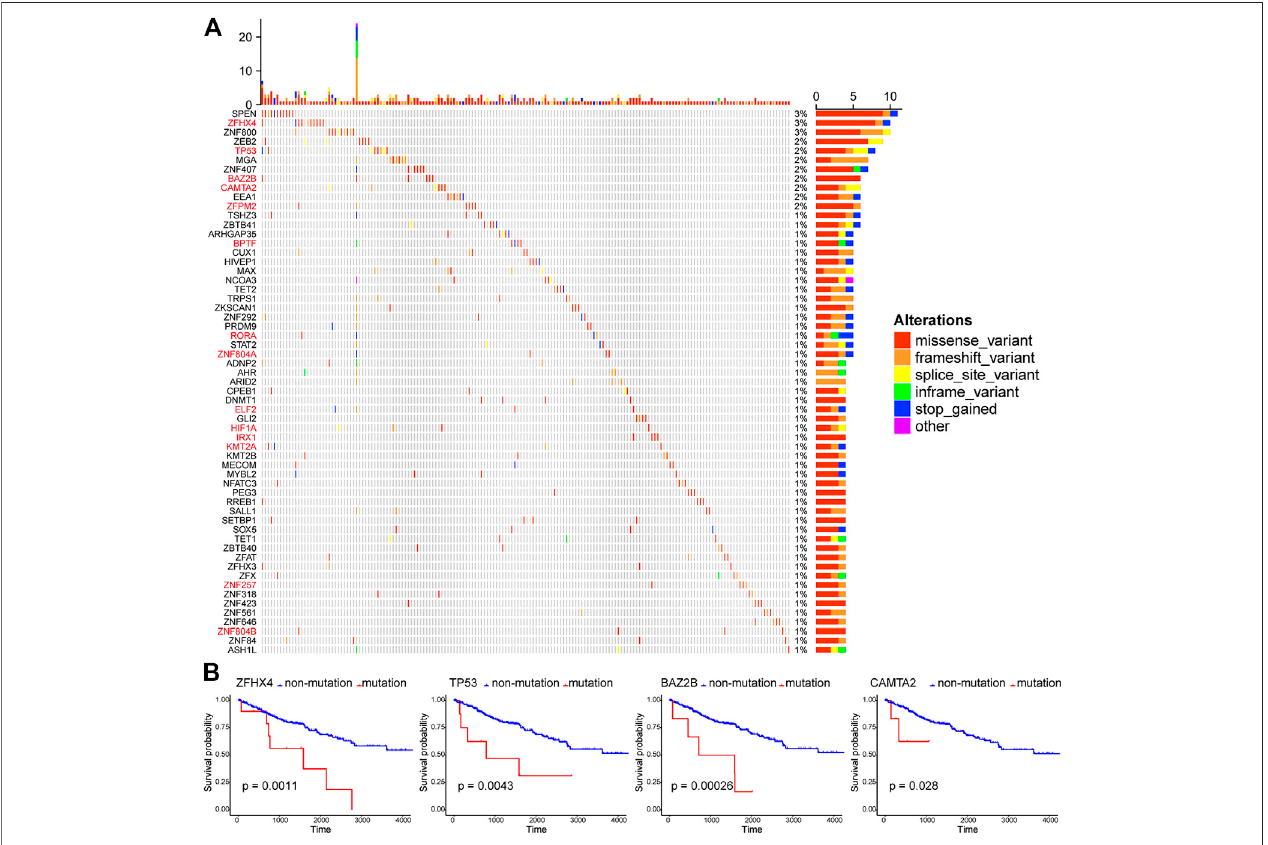
FIGURE 2 | Patterns of gene mutations in ccRCC. (A) The Oncoprint chart shows the top 60 TF genes with most mutations in the TCGA KIRC cohort. The horizontalaxismeansKIRCpatients,andtheverticalaxismeanstheproportionofpatientsampleswithacertaingeneticmutation. (B) OSanalysisofthemutationsofthe four representative TF genes with the most mutations (ZFHX4, TP53, BAZ2B, and CAMTA2). They are all statistically signi fi cant.